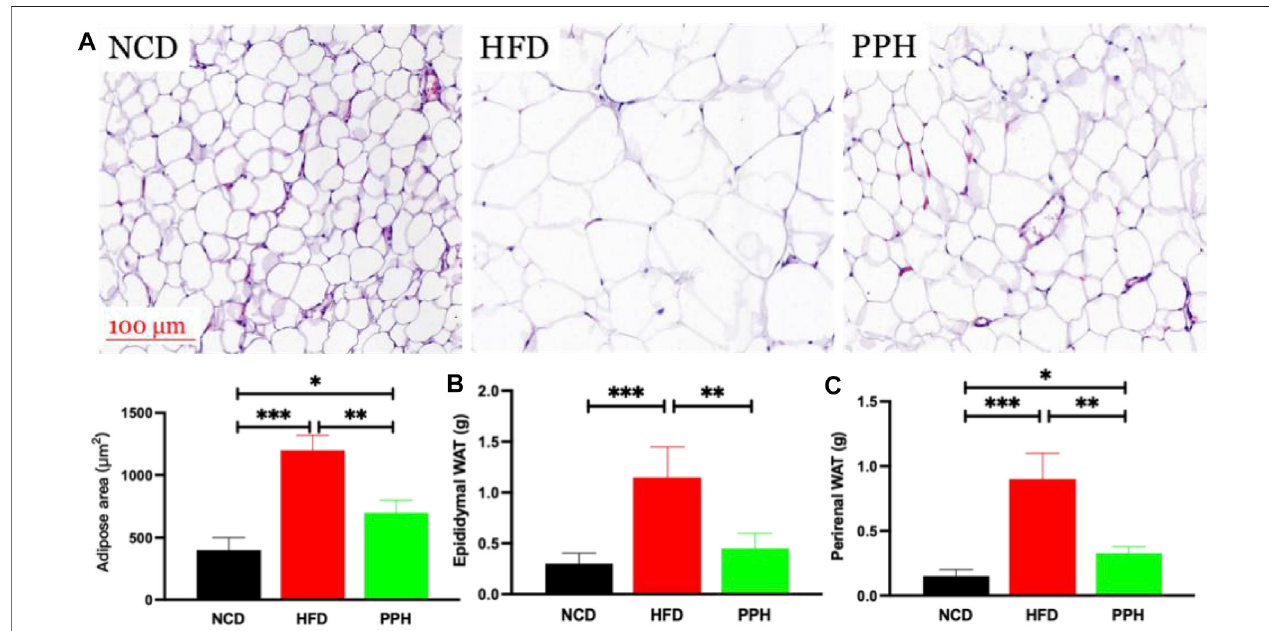
FIGURE 4 | Effects of PPH on activating AMPK signaling pathway in WAT. Western blotting analyses of pAMPK, pHSL, and pACC protein expression in WAT (A) ; quanti fi cation of the pAMPK/AMPK, pHSL/HSL, and pACC/ACC ratios (B) . * p < 0.05, ** p < 0.01, and *** p < 0.001.